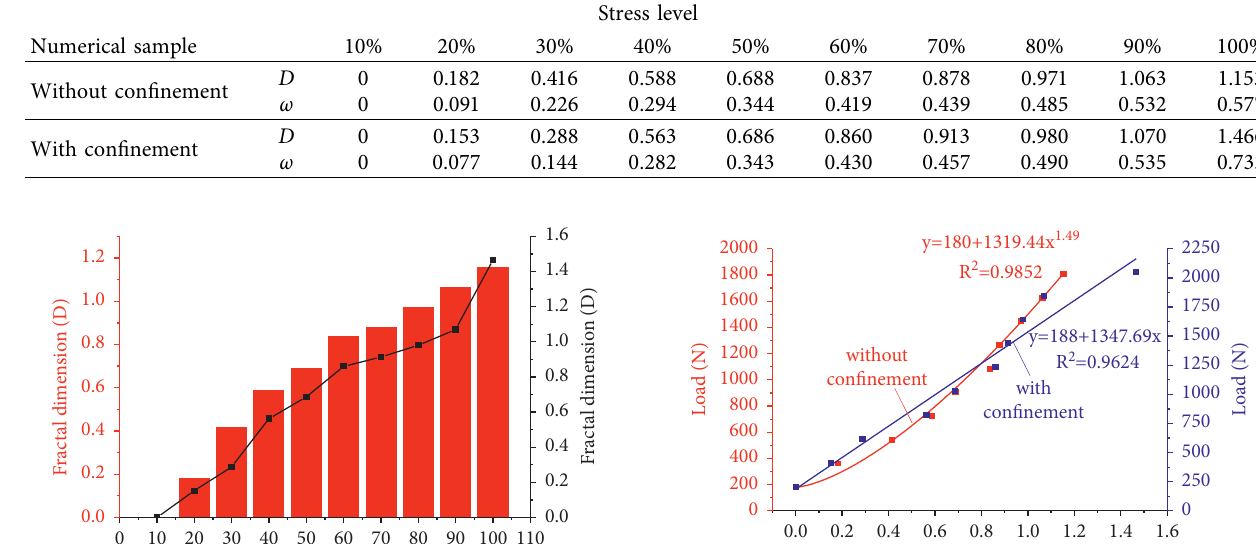
Table 2: The fractal dimension value and damage degree of the specimen under different stress conditions.